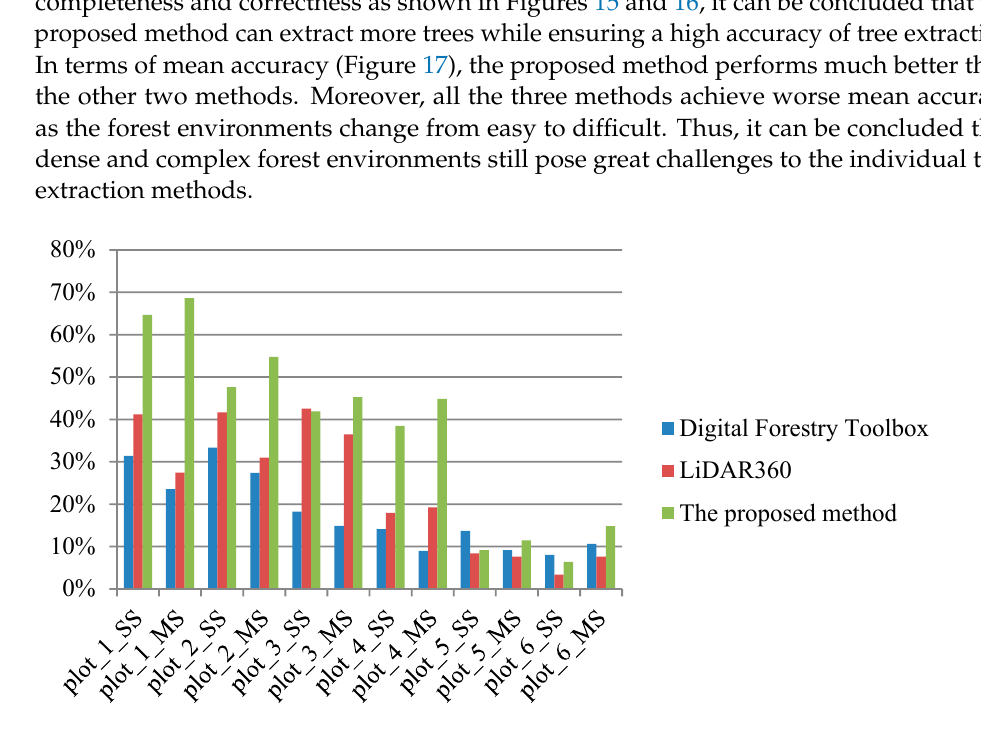
Figure 15. Comparison of completeness of the three methods towards the six plots.